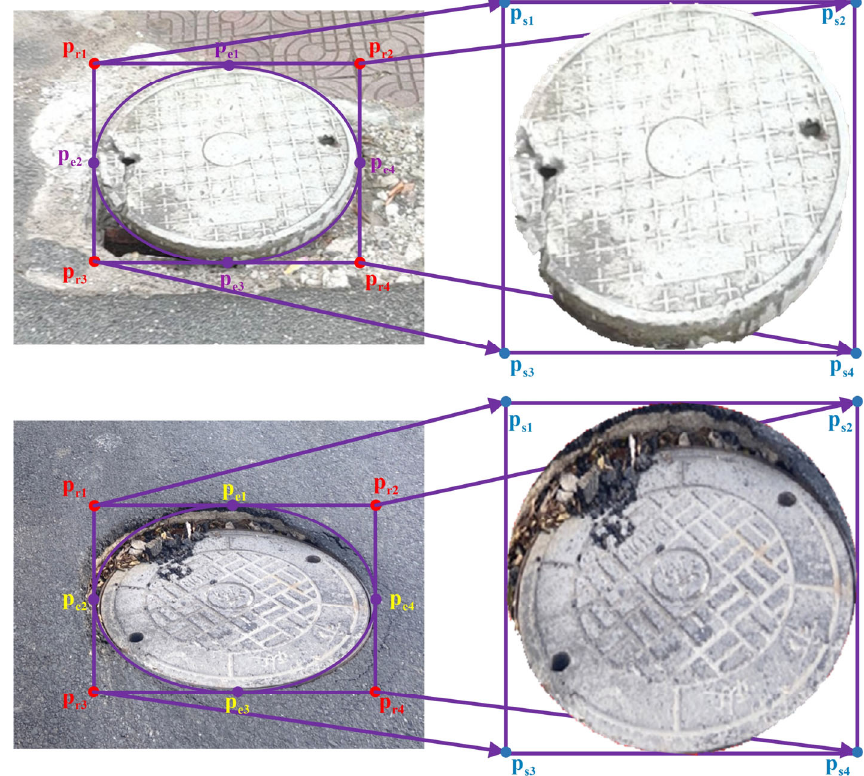
Figure 2. The process of recovering the shape of the manhole cover based on perspective trans ‐ formation. The convex and concave abnormal well covers may have the same complete appearance as normal well covers, but they are often not aligned with the road surface. Therefore, the thickness of the convex well covers and the concave depth of the concave well covers need to be considered when extracting their samples.